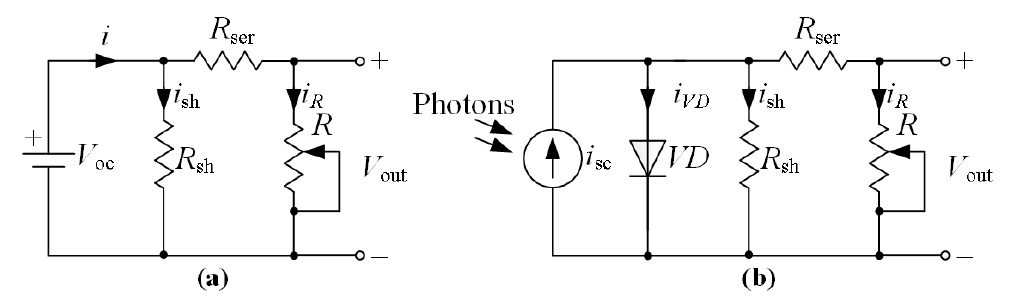
Figure 2. Equivalent circuits of an abstract power source ( a ) and a solar cell ( b